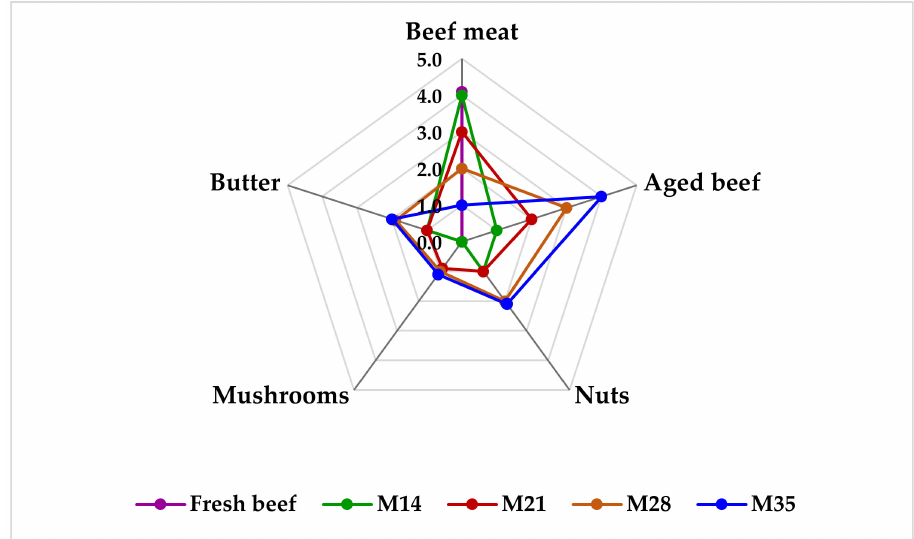
Figure 1. Evolution of the flavor profile of dry-aged meat for 35